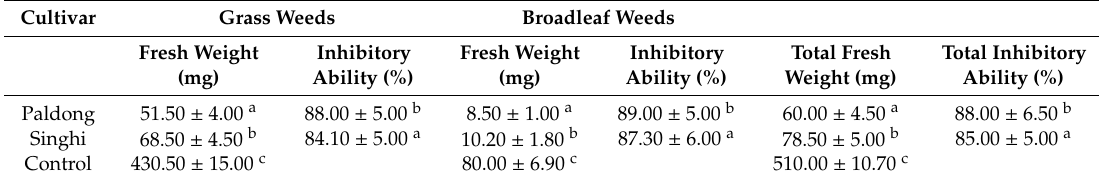
Table 4. Inhibitory ability of di ff erent cultivars of S. cereale on grass and broadleaf weeds in the Perilla